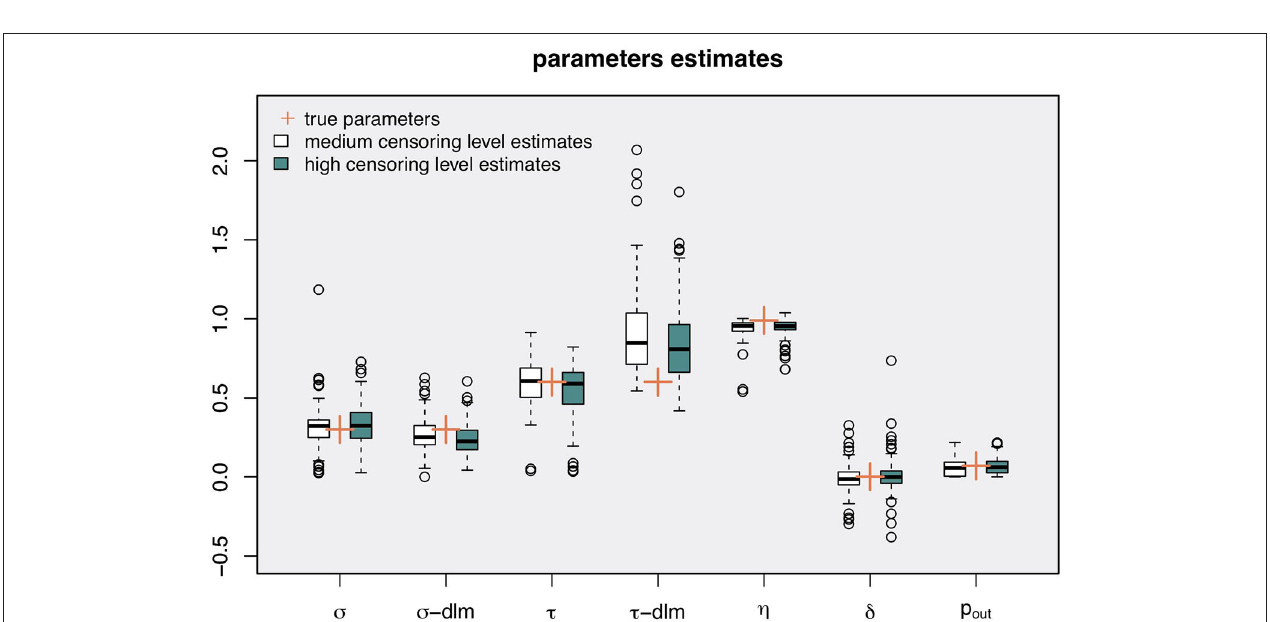
Frontiers in Applied Mathematics and Statistics |